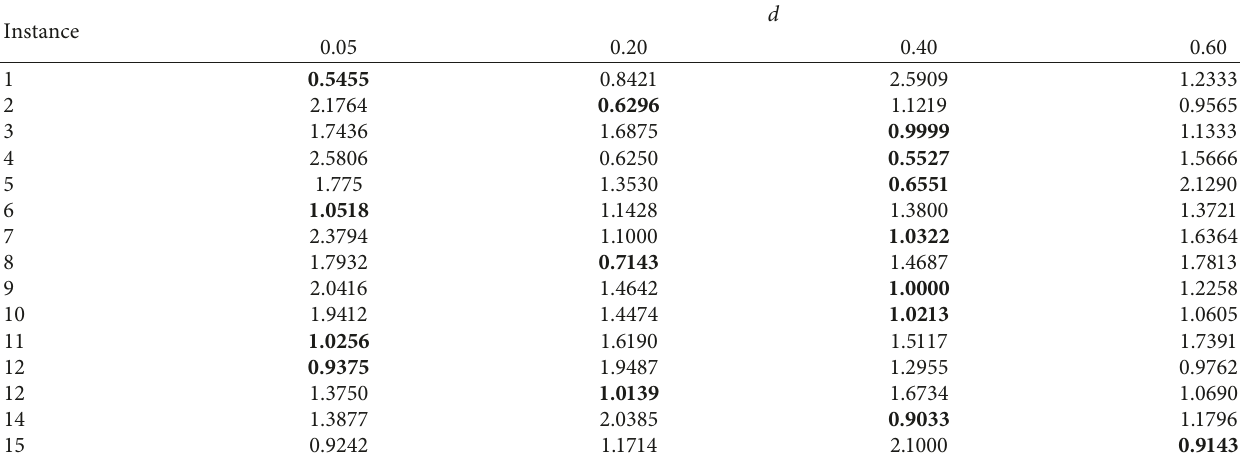
Table 2: Obtained S ( d ) with different values of d .